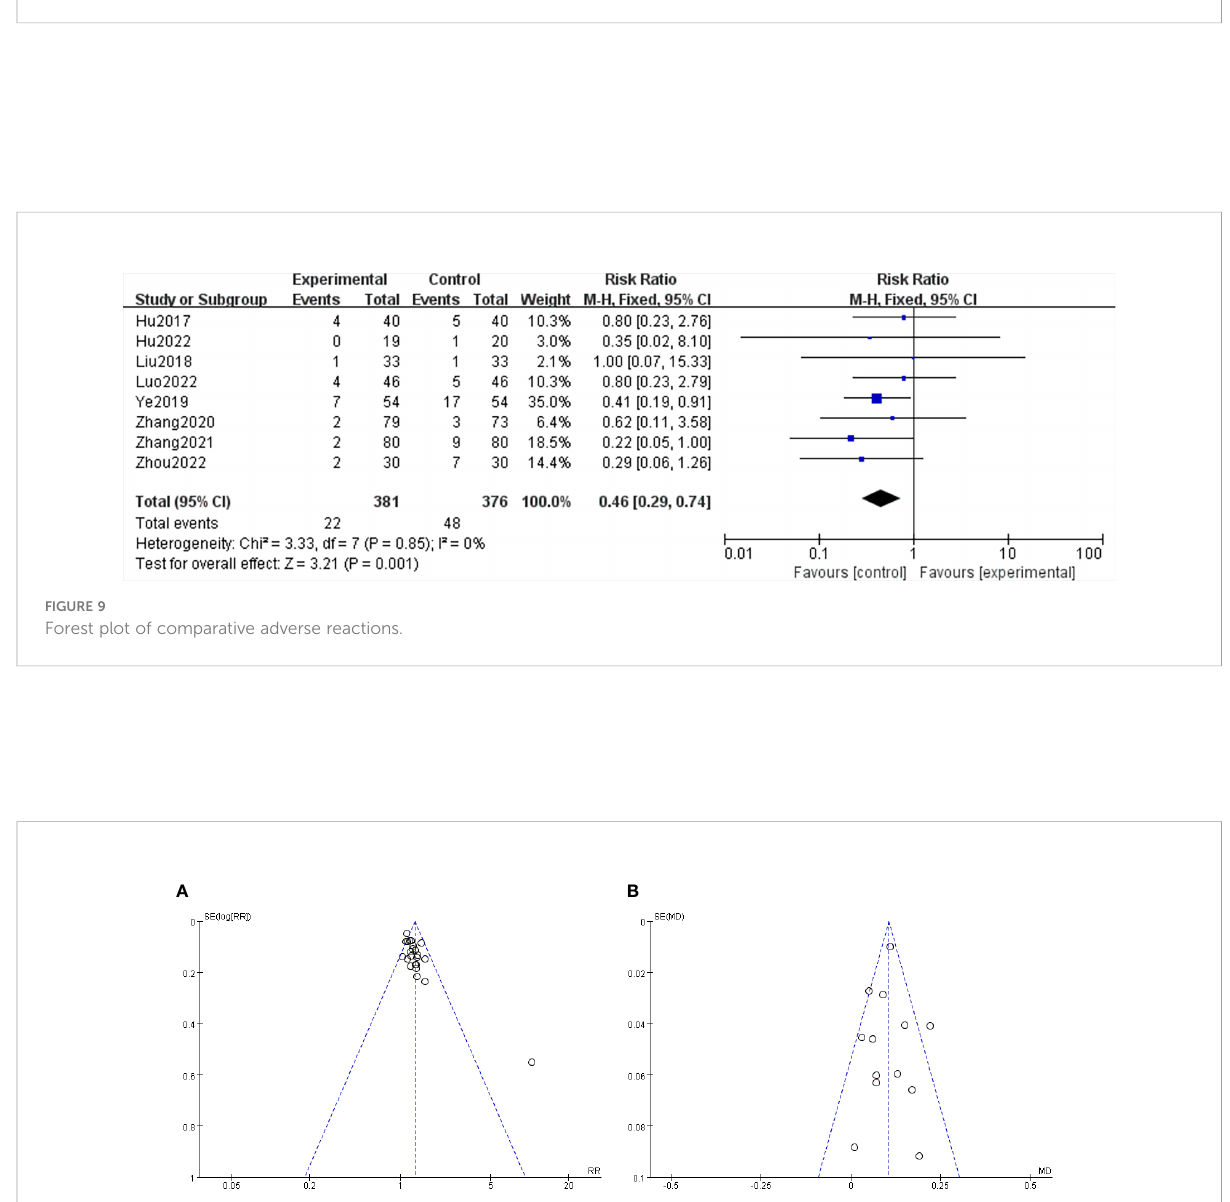
FIGURE 10 (A) Publication bias funnel plot of total clinical response rate. (B) Published bias funnel plot of